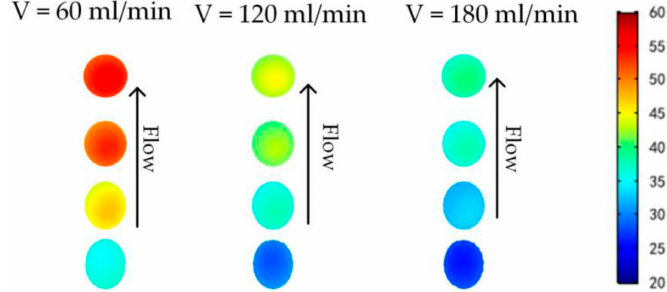
Figure 7. Temperature profile ( ◦ C) over different cross sections along the z -axis at different velocities when the microwave power is 200